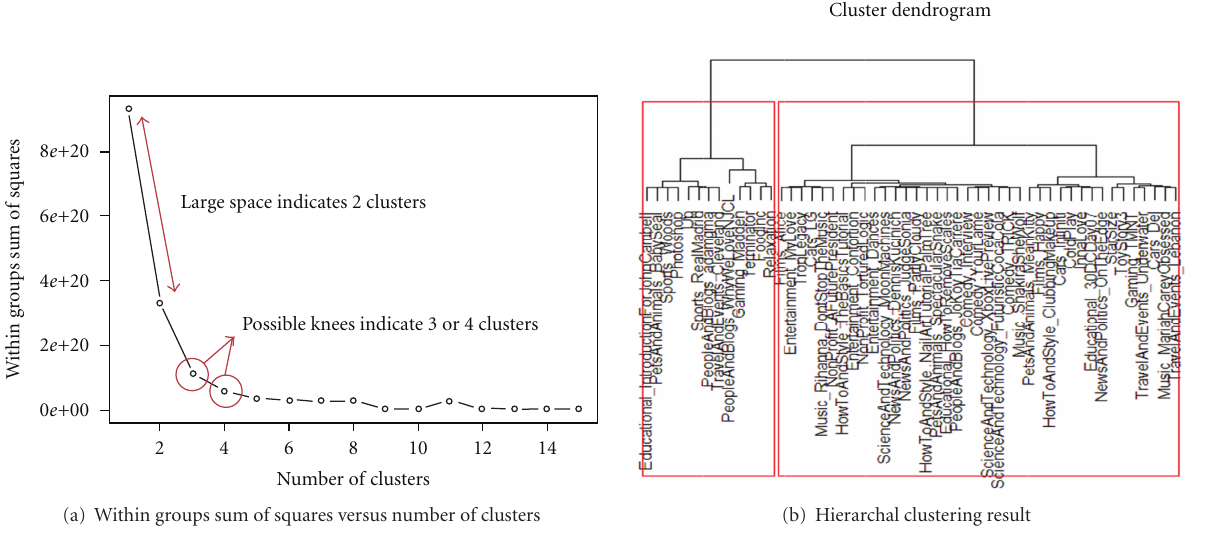
Figure 4: Determining number of clusters using scree test and hieratical analysis.